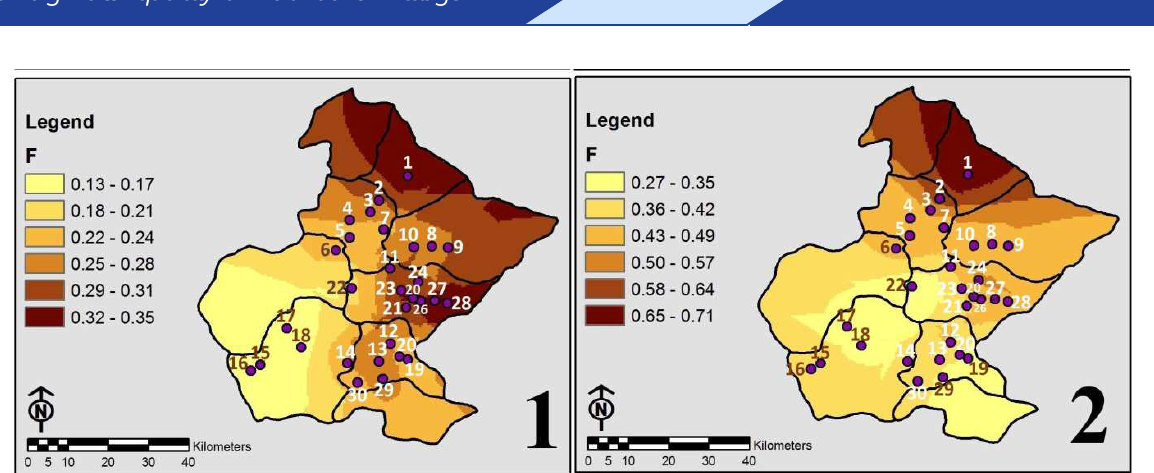
Figure 2. Spatial distribution of fluoride in groundwater in 1: low-water seasons and 2: high- water